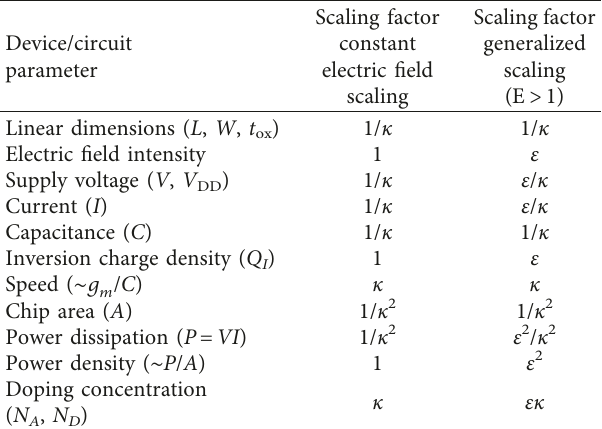
Table 1: Classical device